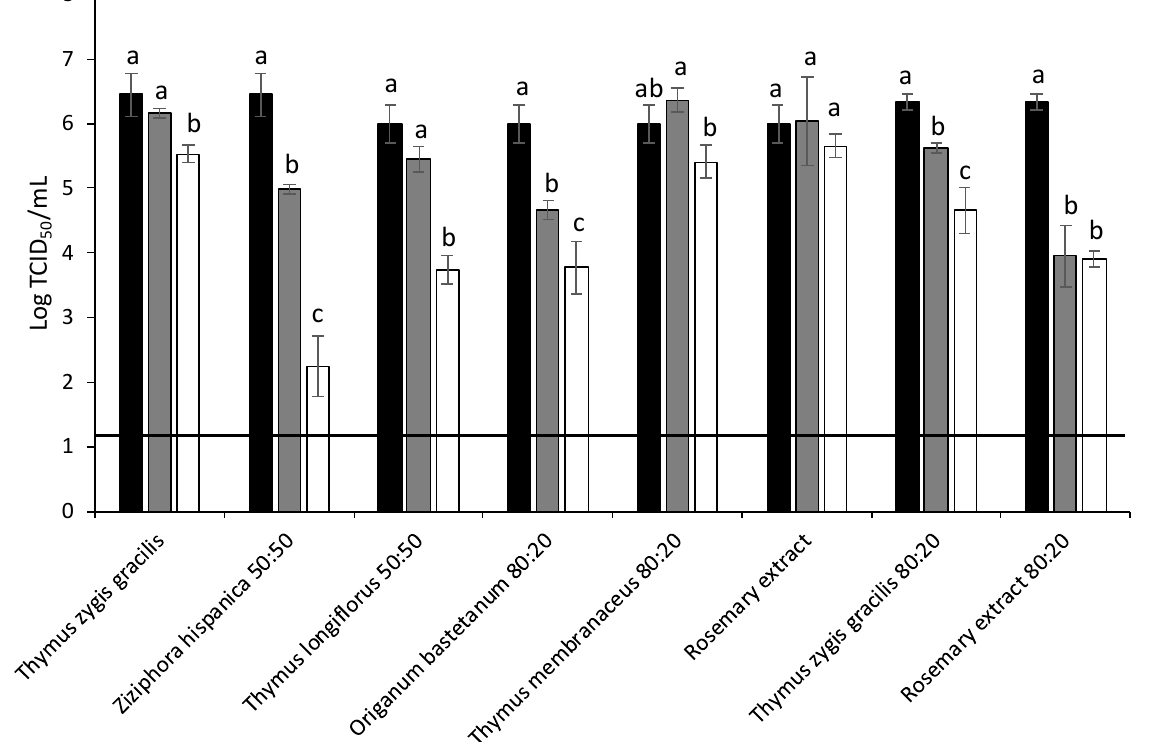
Figure 2. Reduction of feline calicivirus (FCV) titers (log TCID50/mL) treated with different extracts after 25 ◦ C/ON incubations. Black bars: Control; Grey bars: 0.5 mg/mL; White bars: 5 mg/mL. Each bar represents the average of triplicates. Within each column, different letters denote significant differences between treatments. Horizontal line depicts the detection limit.